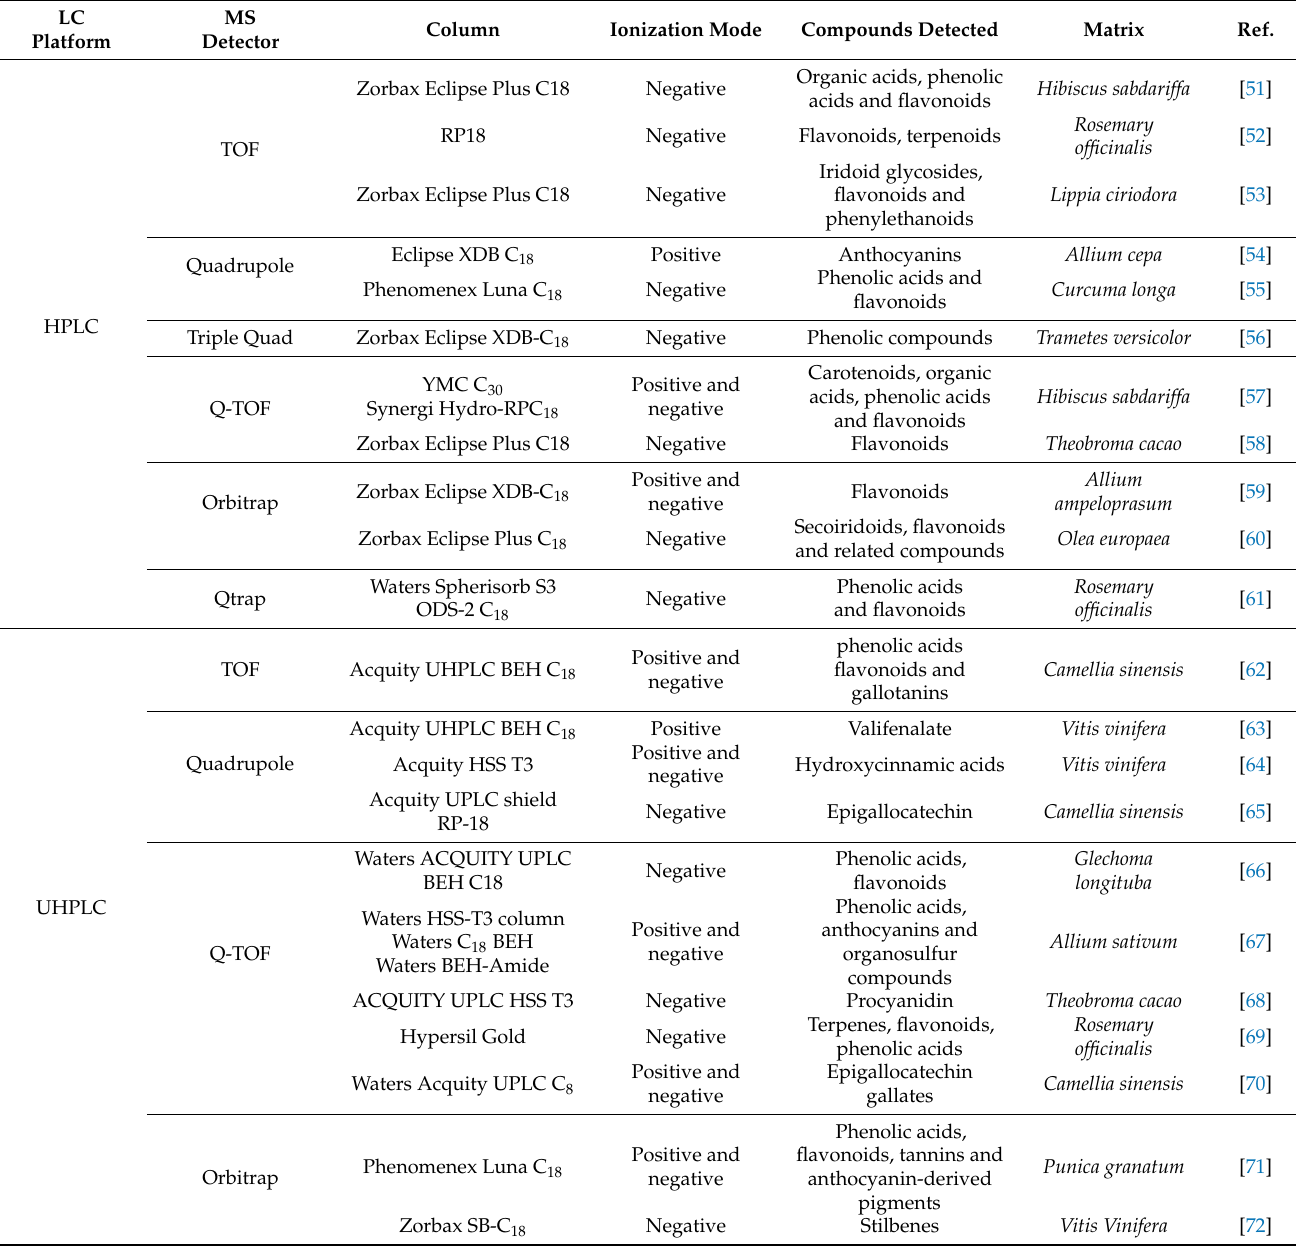
Table 2. Applications of LC to characterize bioactive compound from natural